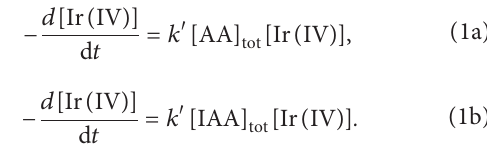
Figure 1: Rapid scan spectra for reduction of [IrCl ascorbic acid (AA). Reaction conditions: [Ir(IV)] � 0.20mM, [AA] tot � 2.00mM, [H + ] � 0.200 M, μ � 1.0 M, temperature of 25.0 ° C. The spectra were acquired at 2, 5, 10, 15, 20, 25, 30, 35, 40, 45, 50, 60, 70, and 80 milliseconds (ms) after